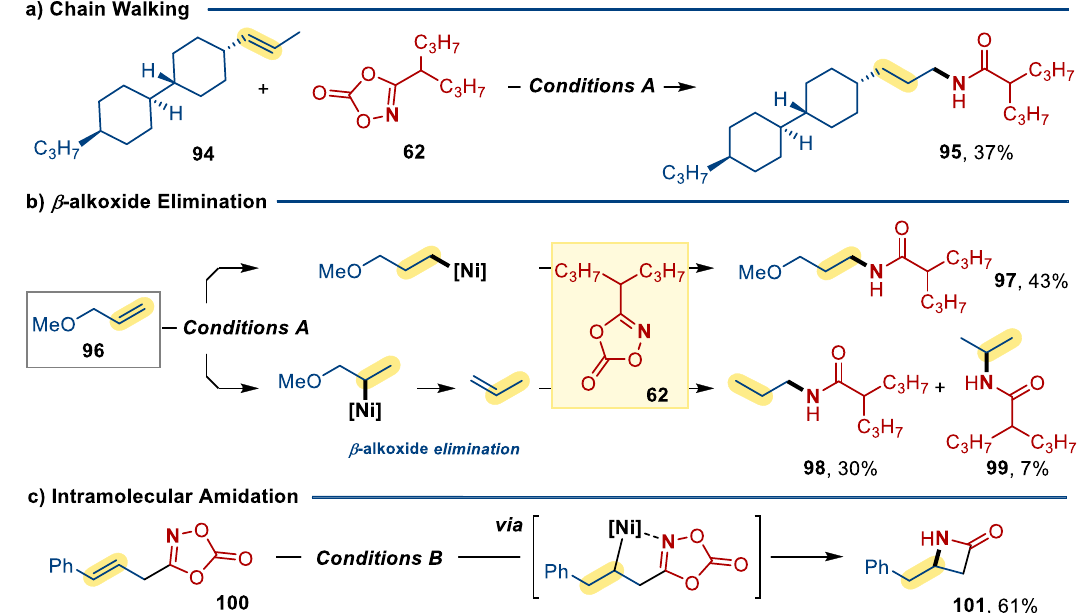
Fig. 4 Examples involving chain walking, β -alkoxide elimination and intramolecular amidation. a Chain walking. b β -alkoxide elimination. c Intramolecular amidation. Conditions A: alkene (0.2 mmol), 62 (0.4 mmol), [Ni(ClO 4 ) 2 ] ∙ 6H 2 O (10 mol %), L4 (12 mol %), HBpin (2.0 equiv), THF + DMA (1.8 + 0.2 ml), in N 2 at room temperature for 12 h. Conditions B: alkene (0.2 mmol), [Ni(ClO 4 ) 2 ] ∙ 6H 2 O (10 mol %), L4 (12 mol %), HBpin (2.0 equiv), MeCN + DCE (1.0 + 1.0 ml), in N 2 at room temperature for 12